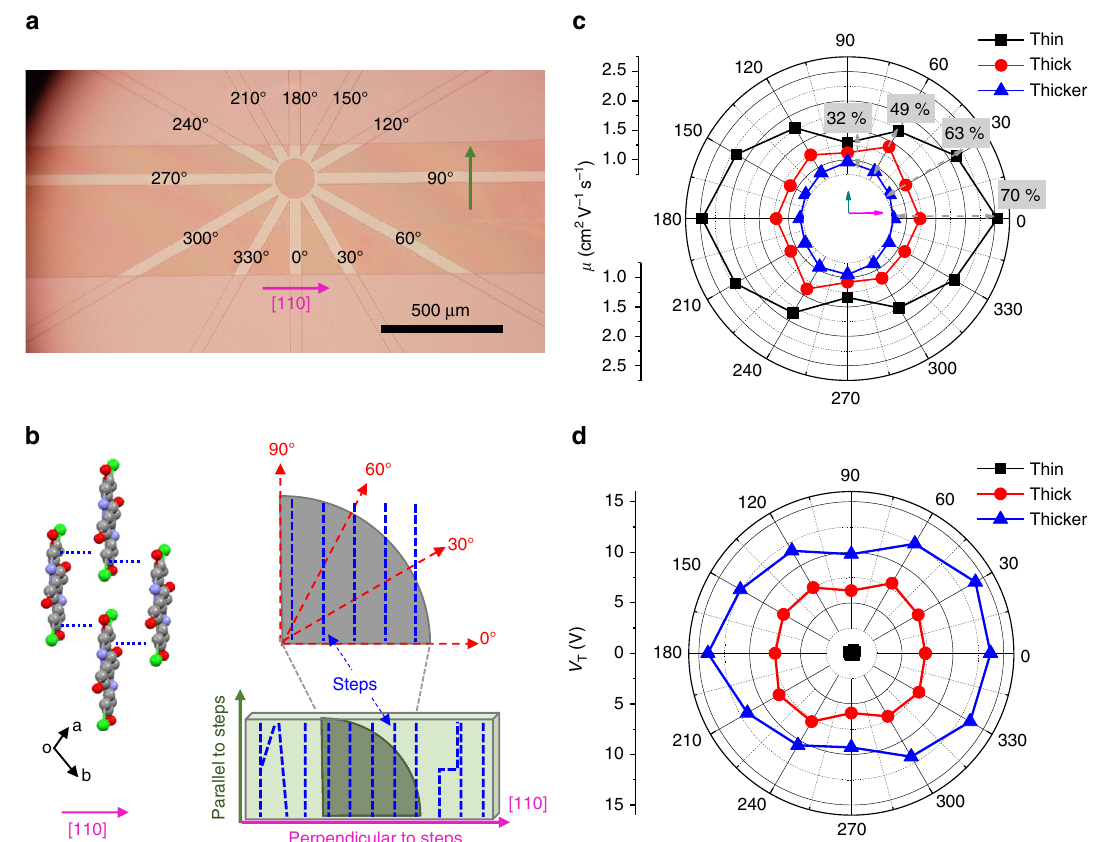
Fig. 2 Angle-dependent charge transport at room temperature for Cl 2 -NDI single crystals with different thicknesses. a Optical micrograph of Cl 2 -NDI vacuum gap FETs for mobility anisotropy measurement. A fan-shaped contact pattern was employed to probe transport in different angular directions. 0° corresponds to the [110] direction and the crystal long-axis. b Crystal packing structure (left, CH 2 C 3 F 7 omitted for clarity and black dashed lines represent π – π intermolecular interactions) and schematic diagram of crystal steps (blue dashed lines) on the (001) crystal facet (right). Crystal steps are almost perpendicular to the [110] direction. c , d Mobility and V T anisotropy, respectively, for Cl 2 -NDI devices with different crystal thicknesses. Inserted percentages on the mobility polar plot in c represent mobility degradation [( μ thin − μ thicker )/ μ thin ] in the respective